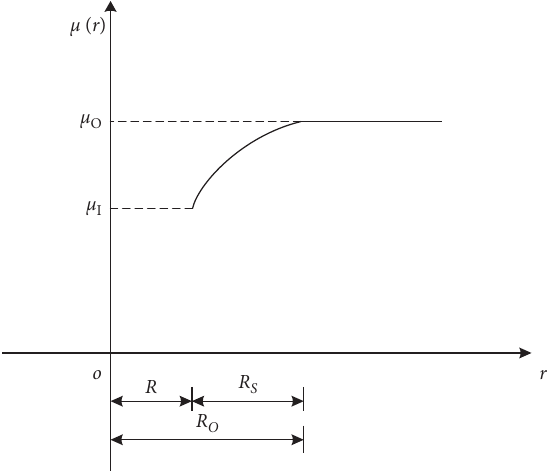
Figure 2: Varying law of soil shear modulus along radial